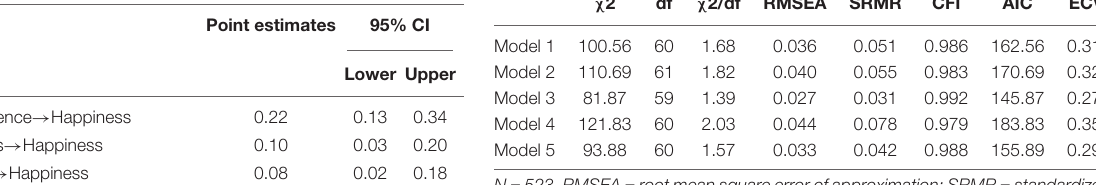
N = 523, RMSEA = root mean square error of approximation; SRMR = standardized root-mean-square residual; CFI = comparative fit index; AIC = Akaike information criterion; and ECVI = expected cross-validation